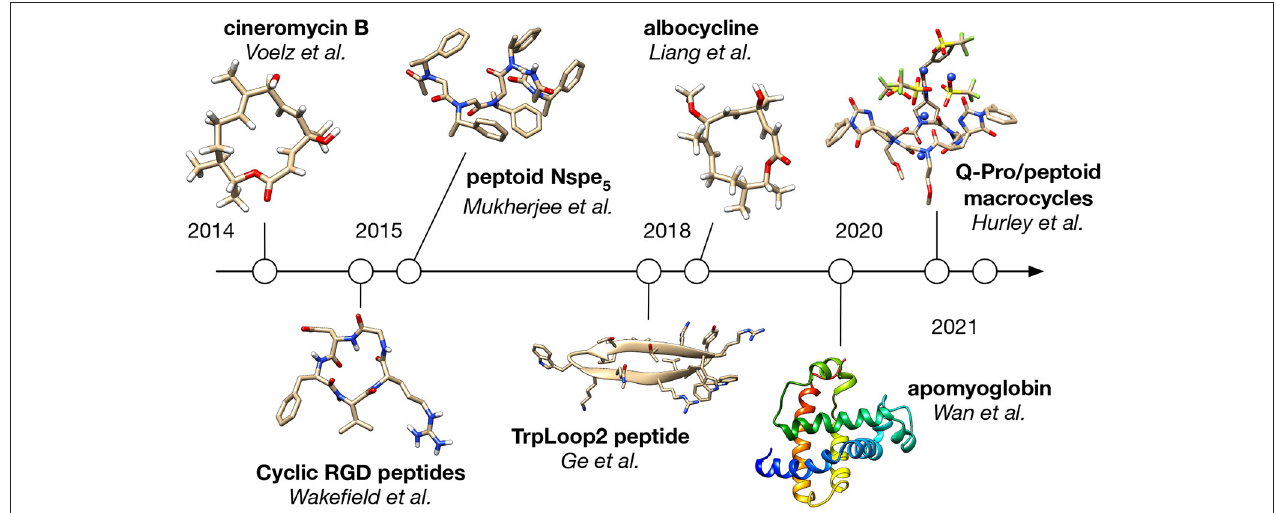
FIGURE 2 | A timeline of BICePs